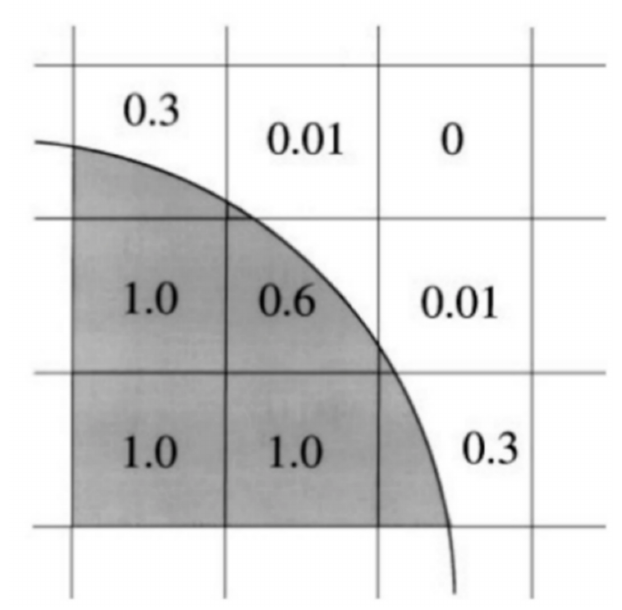
Figure 3. Interface representation in the VOF method